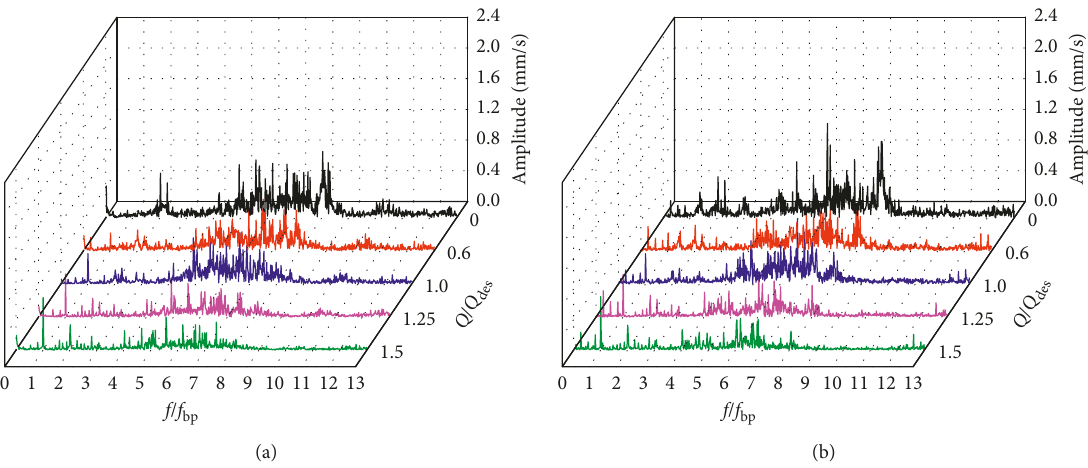
Figure 5: Vibration frequency spectrum at the pump outlet: (a) CH7; (b) CH8.